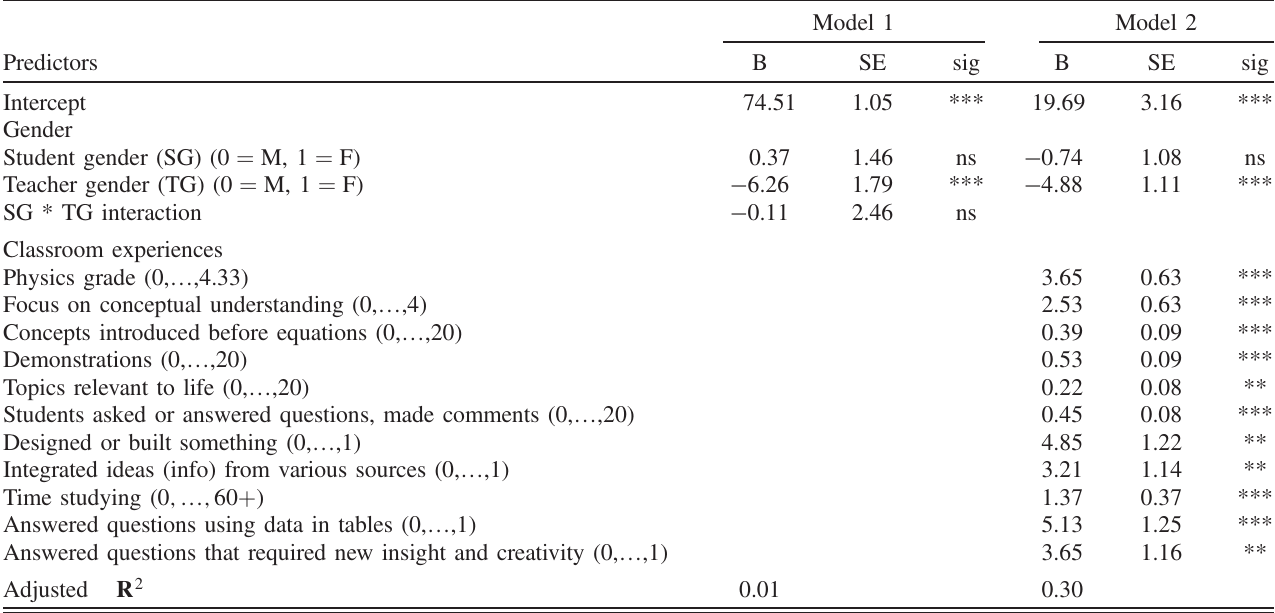
TABLE II. Regression models incorporating student evaluations of physics teachers (100 point scale) with gender and classroom experiences. Note that ***: p < 0 . 001 , **: p < 0 . 01 , *: p < 0 . 05 , ns: not